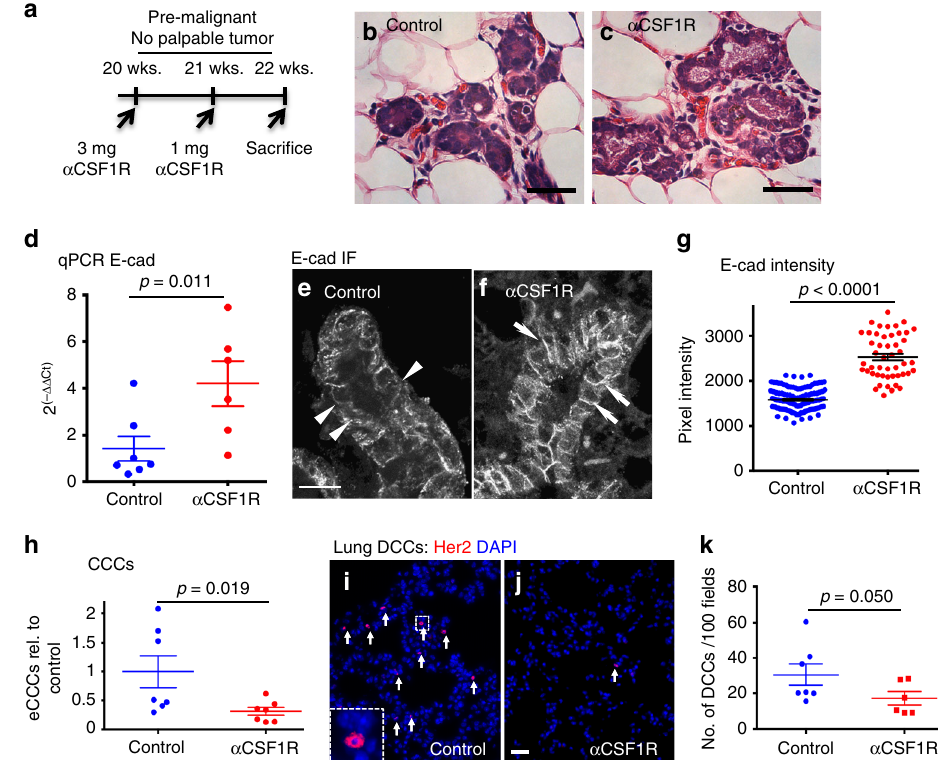
Fig. 3 Macrophage depletion during pre-malignant stages prevents early cancer cell dissemination. Twenty-week-old pre-malignant MMTV-HER2 mice were treated with the anti-CSF1R ASF98 antibody and animals were harvested after 2 weeks with no signs of invasive carcinoma ( a ). Analysis of H&E staining of mammary gland sections con fi rmed the absence of invasive lesions ( b , c ; bars: 100 μ m). E-cadherin expression in whole mammary glands was determined ( d ; mean ± SEM; control 7, anti-CSF1R 6 animals; statistical analysis: Mann – Whitney test) and by immuno fl uorescent staining against E- cadherin in mammary gland sections ( e , f ; bars: 10 μ m). E-cadherin signal intensity was measured in individual regions of cell junctions in three animals per group ( g ). P values were calculated with 95% con fi dence interval by Mann – Whitney test. Early circulating cancer cells (eCCCs) were quanti fi ed in mice per group as the amount of HER2 and CK8/18 + eCCs/ml peripheral blood. Values were normalized to the mean of controls and are shown as mean ± SEM ( h ) depicts normalized mean ± SEM; seven animals per group; statistical analysis: Mann – Whitney test. Disseminated HER2 + eCCs were quanti fi ed in lung sections ( i , j ; bars: 25 μ M) and were quanti fi ed as the average of HER2 + cells per 100 randomly chosen microscopic fi elds ( k ). Mean ± SEM are